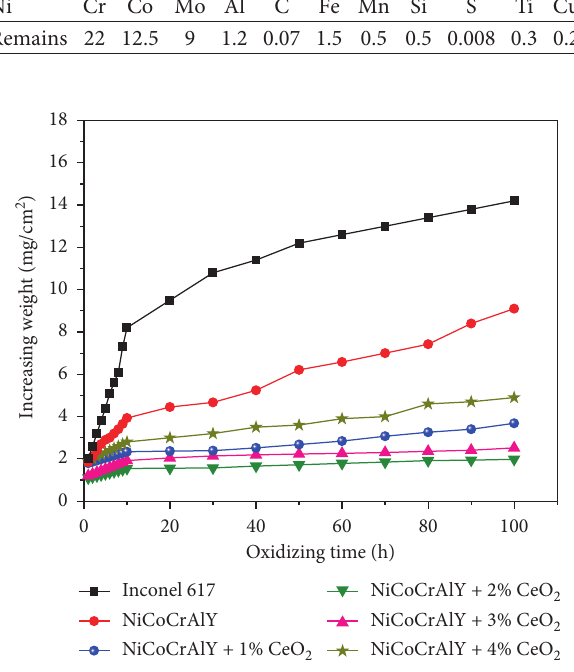
Figure 1: Oxidation kinetics of the substrate and